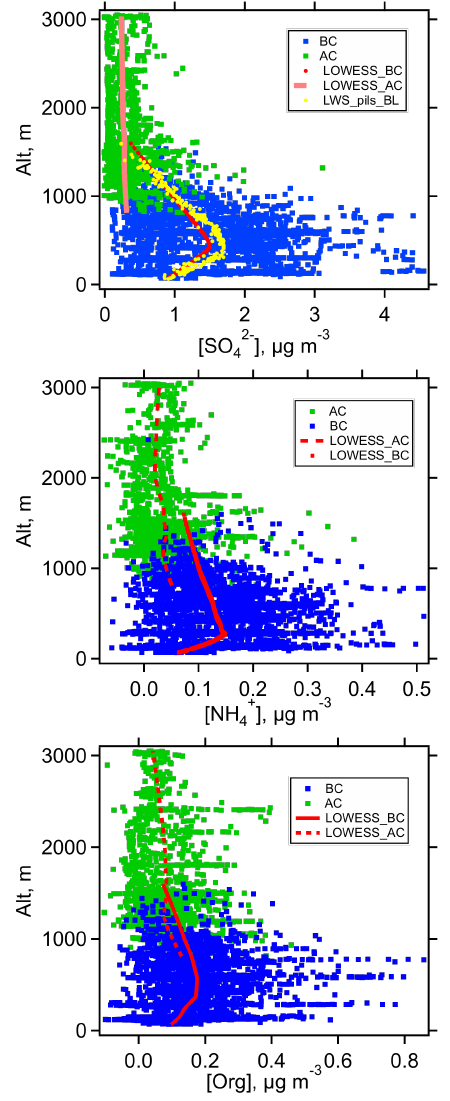
Figure 6. Composite vertical distributions of the concentrations of SO 2 − , NH + , and Org for the entire G-1 mission. Continuous lines 4 4 (dashed as well as solid) represent LOWESS